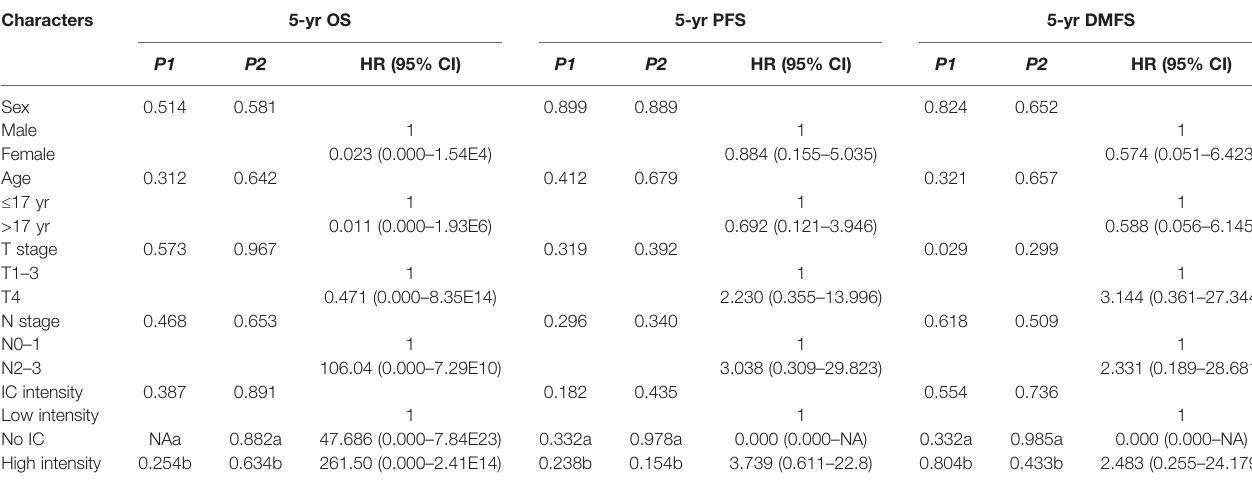
TABLE 3 | Univariate and multivariate analysis for potential prognostic factors in clinical outcomes for patients in the low risk group.